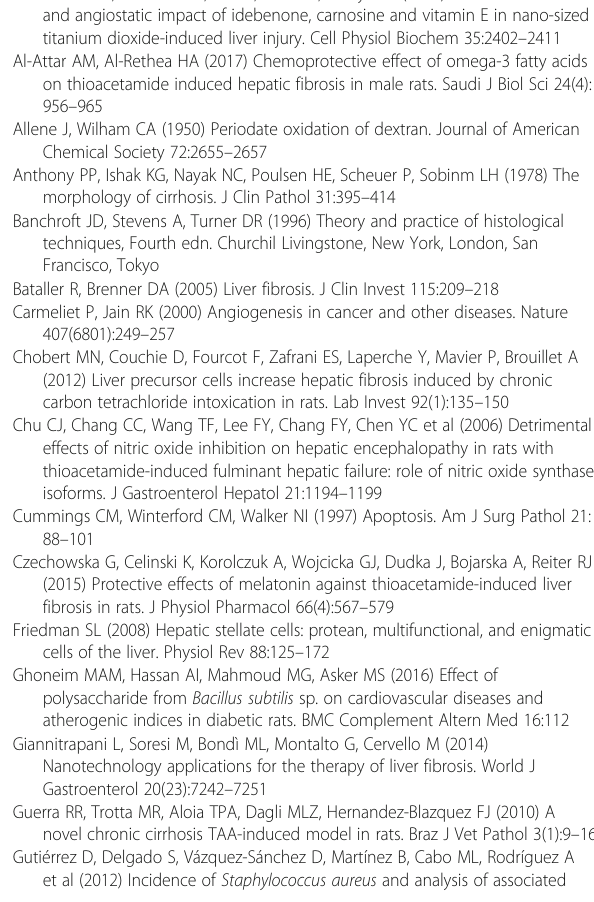
Table 4 Histopathological changes in the liver of rats exposed to TAA and the treatment effect of Ag-BSEPS, based on scoring severity of injury Observation Control (GI) TAA (GII) Focal area in the degenerated hepatocytes − ++++ - + Congestion in the blood vessels − ++++ − ++ Inflammatory cells − ++++ − − Necrosis _ ++++ − _ Massive fibrosis _ ++++ _ _ Hepatocytes degeneration ++++ _ _ Normal ( − ), minimal (+), mild (++), severe collagen synthesis and its breakdown consequently, pre- venting the destruction or fibrosis of the liver. The anti- fibrotic effect of Ag-BSEPS may affect inflammation, inhi- biting the oxidative stress concomitant lipid peroxidation which are implicated in the genesis of liver fibrosis and modulation of TGF- β . Therefore, Ag-BSEPS conspicu- ously increased GSH-PX, SOD, and CAT quantities. The current outcomes propose that Ag-BSEPS is a prospective agent for the cure of liver fibrosis due to simple technol- ogy to produce drug-containing nanoparticles of a silver core coated with BSEPS having a stable structure without using any organic solvent or surfactant.